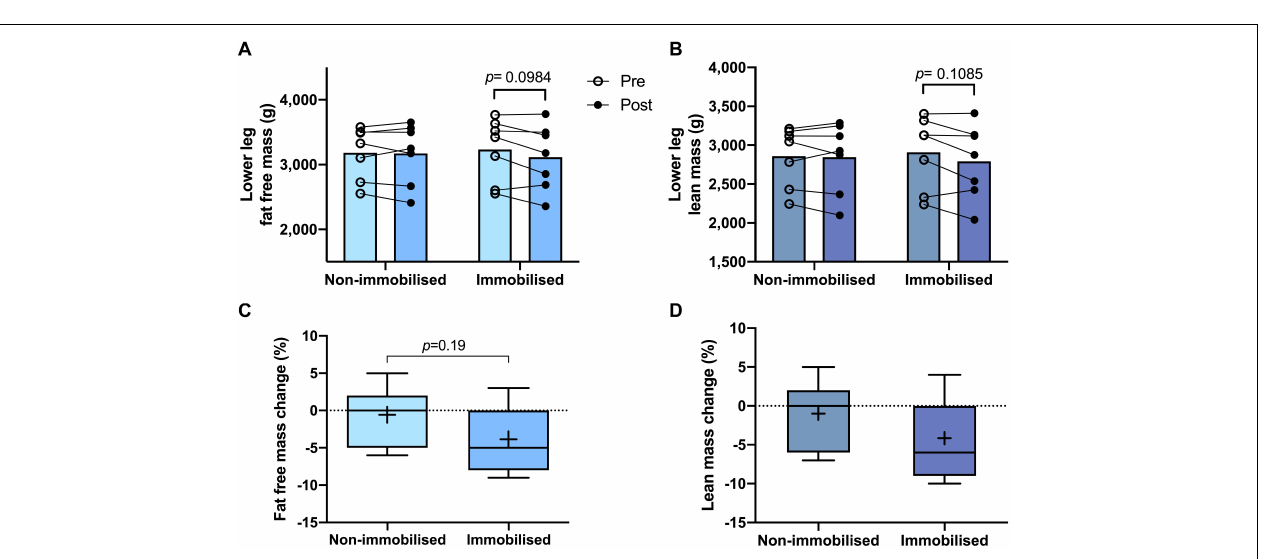
FIGURE 2 | (A) Quantification and representative images of muscle fibre type distribution in (B) tibialis anterior (TA) and (C) medial gastrocnemius (MG). Type I fibres: light; Type II fibres: dark. Values are mean, with individual values.